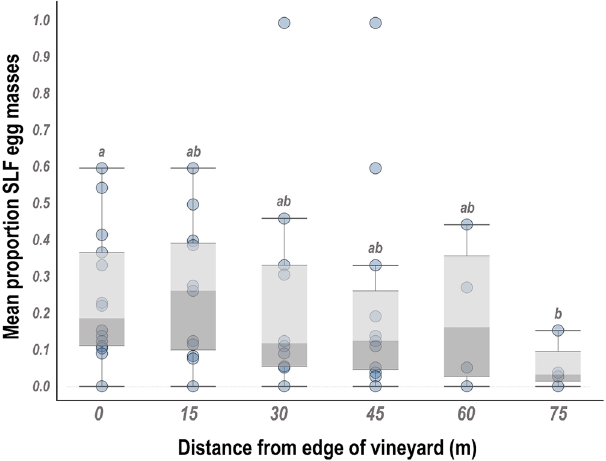
Figure 2. Mean proportion spotted lanternfly (SLF) egg masses found sampling distances from vineyard edge, 0 m (at vineyard edge) to 75 m into the vineyard block. A total of 8 vineyards were sampled for SLF egg masses during 2018 and 2019. Bands for each distance represent 95% confidence interval. Different letters denote significant differences between distances at alpha = 0.05.